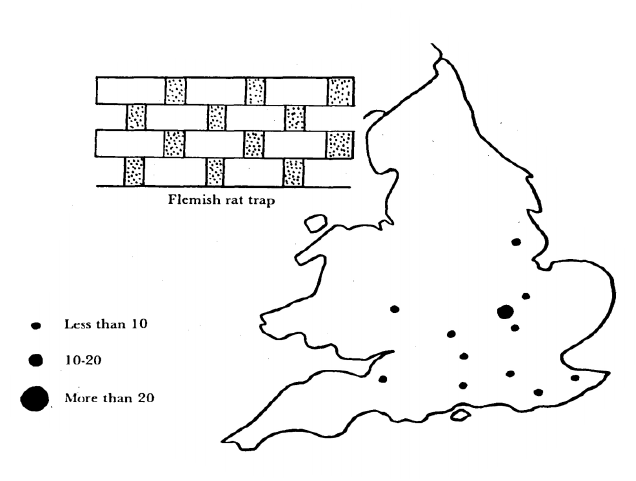
Fig. 2. Map showing usage of RTB in England and Wales